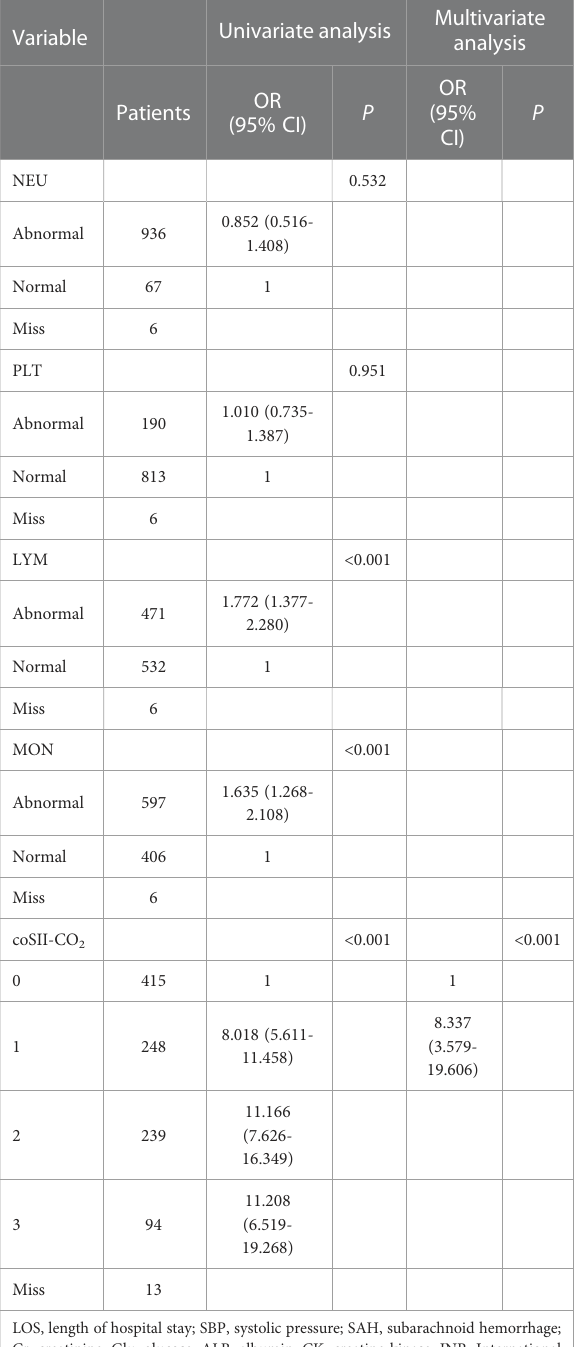
LOS, length of hospital stay; SBP, systolic pressure; SAH, subarachnoid hemorrhage; Cr, creatinine; Glu, glucose; ALB, albumin; CK, creatine kinase; INR, International Normalized Ratio; CRP, C-reactive protein; NEU, neutrophile; LYM, lymphocyte; MON, monocyte; SII, platelets × neutrophils/lymphocytes; NLR, neutrophil/ lymphocyte ratio; PLR, platelet/lymphocyte ratio; LMR, lymphocyte/monocyte ratio; CO2, carbon dioxide; coSII-CO2, Systemic immune in fl ammatory index combined with carbon dioxide; GOS, Glasgow Outcome Scale. Patients with high SII and low CO2 were assigned 3 points, patients with high SII and high CO2 were assigned 2 points, patients with low SII and low CO2 were assigned 1 point, and patientswithlowSIIandhighCO2wereassigned 0points. P<0.05was consideredto indicate statistically signi fi cant